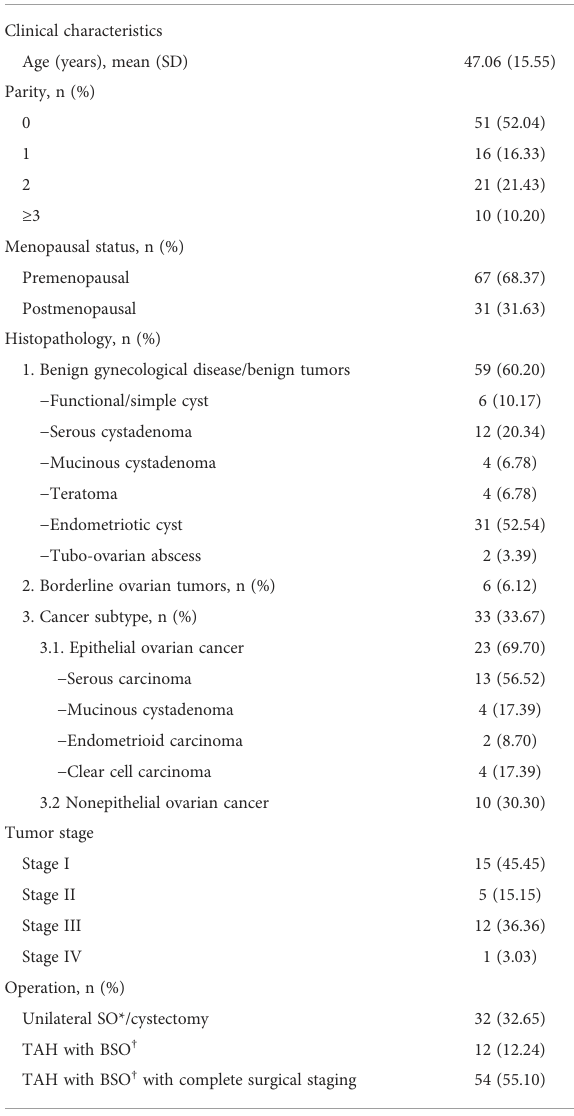
TABLE 1 Baseline characteristics and histopathology of the participants who presented with pelvic and adnexal masses.